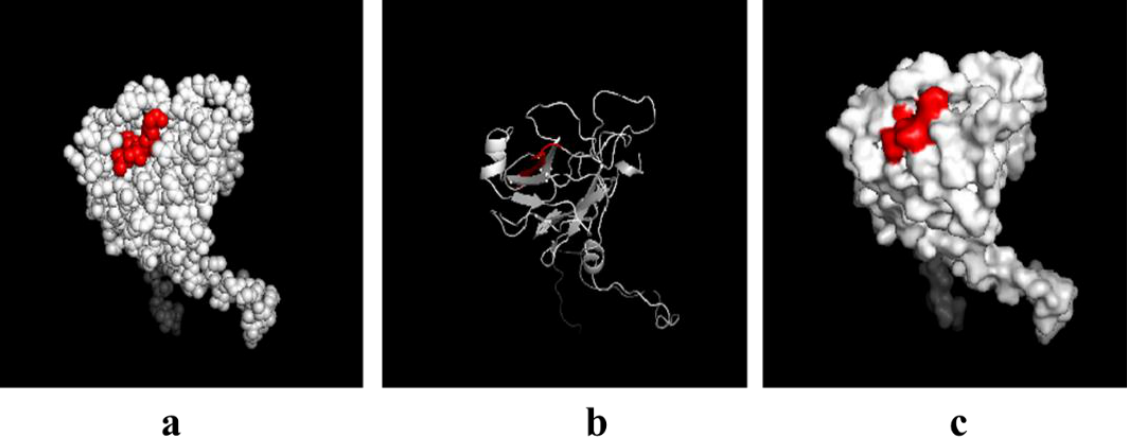
Figure 7. Spatial distribution of the identified epitope on the VP3. The relative spatial position of the identified epitopes is presented in spheres ( a ), and cartoon ( b ) from the predicted three-dimensional structure of SVA VP3, and the epitope recognized by VP3 is shown in red. The epitope is located on the surface of the protein ( c ).